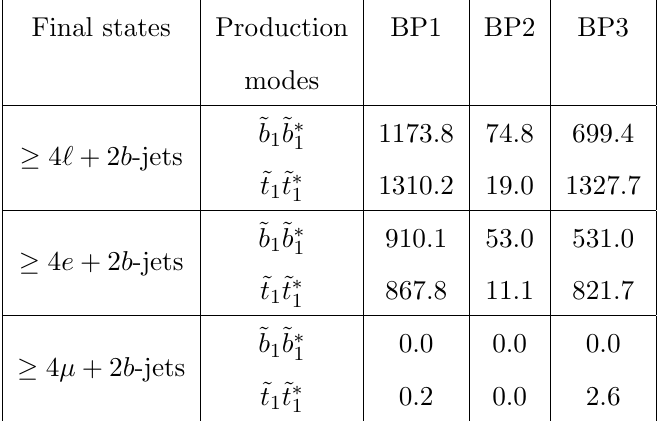
Table 4. Final state numbers for 4 ‘; 4 e; 4 (cid:22) along with 2 b -jets for the benchmark points at 100 fb (cid:0) 1 at the LHC with 14 TeV, where the contributions are from ~ b 1 ~ b (cid:3)